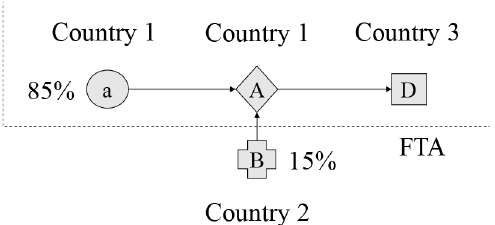
Figure 2 An example illustrating rule of origin for the FTA between two countries